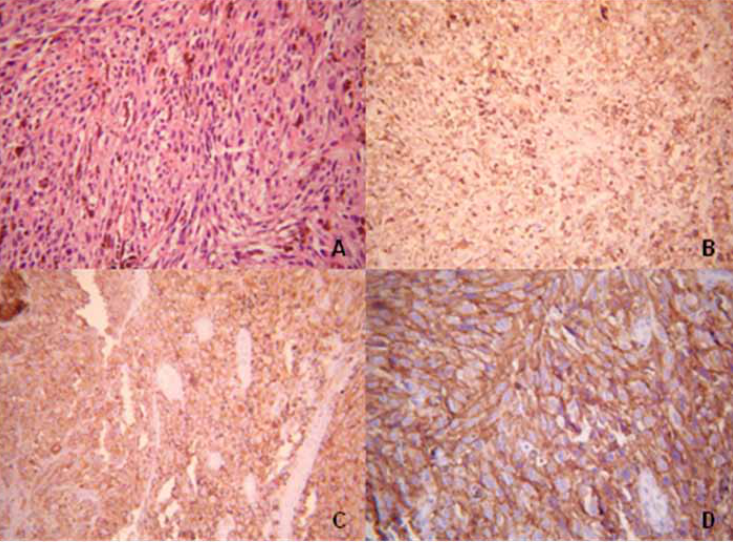
Figure 2 - Slides of malignant melanoma of the penis: A) Malignant melanoma showing spindle cell area, containing atypical melanocytes. (HE - 200x). B) Same case immunostained for HMB45 (400x). C) Immunoreativity for Melan - A (400x), a product of gene MART 1. D) c-KIT (400x), product of c-kit gene expression. It is a transmembrane